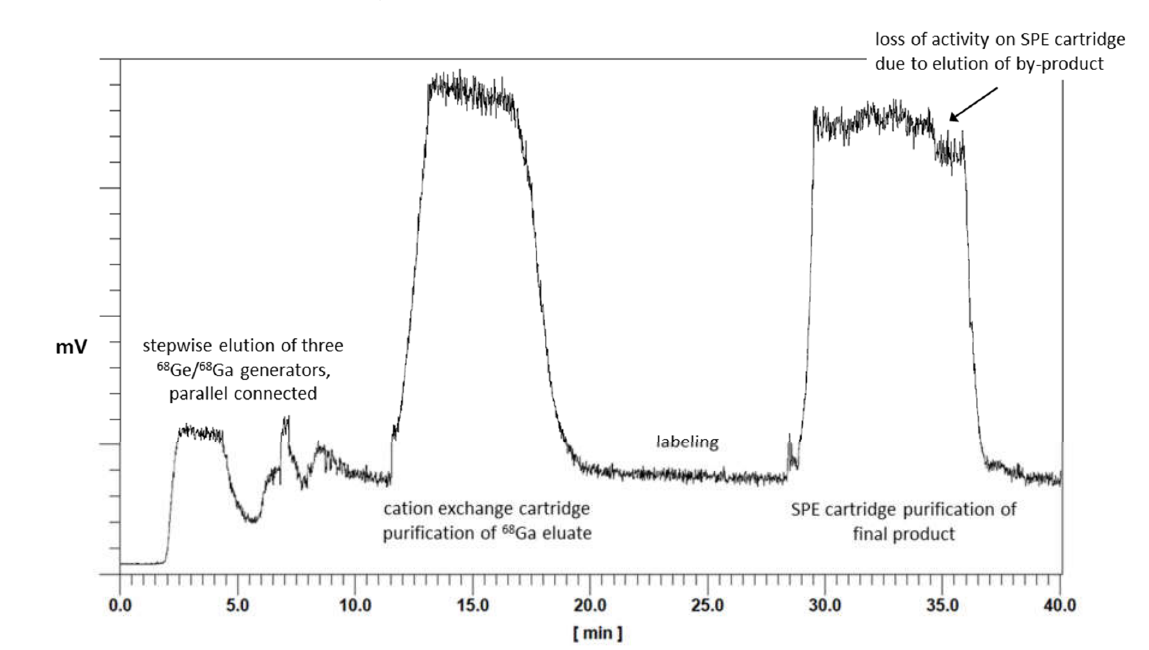
Figure 4. Chromatogram of activity sensors during the automated synthesis of a batch of [ 68 Ga]Ga- TEoS-DAZA. The overall synthesis time is 40 min. The GMP productions of [ 68 Ga]Ga-TEoS-DAZA and [ 68 Ga]Ga-TMoS-DAZA